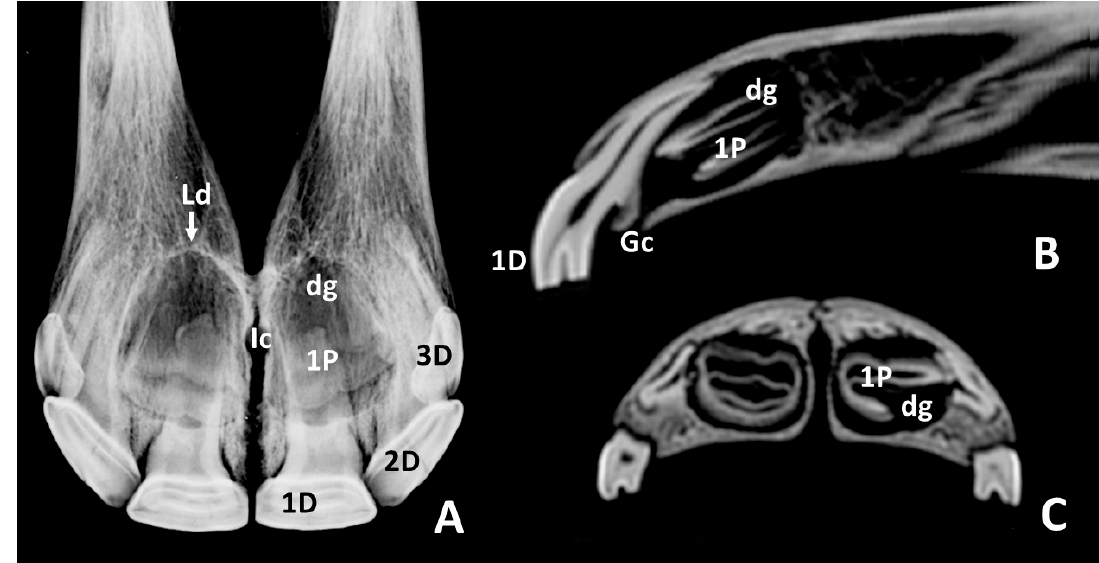
Figure 5. Intraoral radiographic images ( A ) and sagittal and transverse scans ( B , C ) of maxillary incisor arcade of one skull representative of group 1c. 1D , left 1st deciduous incisor—601; 2D , left 2nd deciduous incisor—602; 3D , left 3rd deciduous incisor—603; 1P , left unerupted 1st permanent incisor—201; dg , dental germ of left 1st permanent incisor—201; Gc , gubernacular canal of left 1st